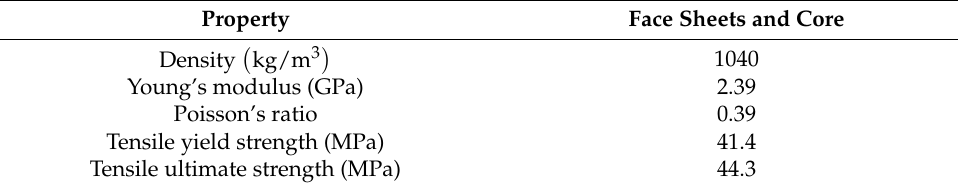
Figure 5. SPS models with different TPMS lattice cores: ( a ) SP, ( b ) S2, ( c ) I-WP and ( d ) F-RD. Table 3. Wall thicknesses of TPMS lattices at different relative densities. Table 4. Mechanical properties of ABS